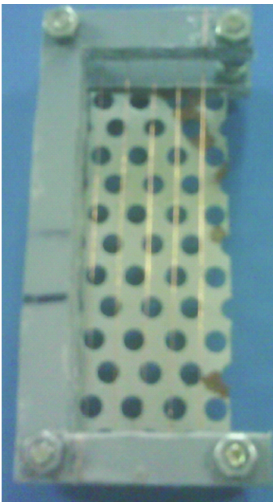
Figure 3: Wire-to-plate electrode configuration.